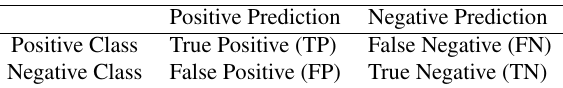
Table 2. Confusion matrix for a two-class